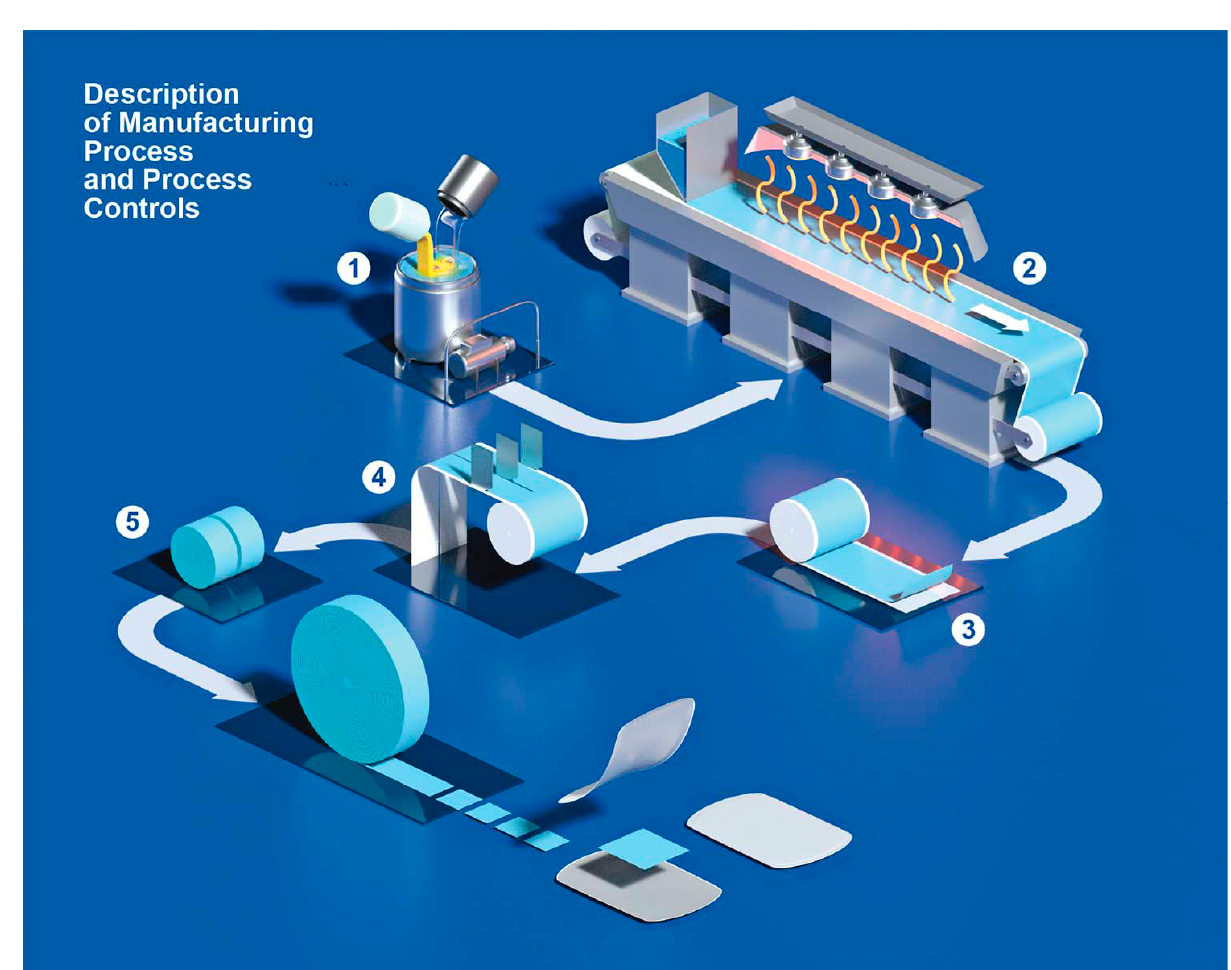
Figure 3. Description of industrial manufacturing process of ODF. The solvent-casting method, used to manufacture orodispersible films, consists of several steps. 1: During the first step, a liquid mixture is prepared; temperature and stirring speed are the critical process parameters. 2: Afterwards, the mixture is spread and dried in a drying tunnel by controlling temperature, air circulation, humidity and coating speed. 3: The dried and spread mixture is wound to form a big roll, called a Jumbo roll. 4: The jumbo roll is unwound to undergo two consecutive cutting phases, where the size of the film strips is selected and the final dosage is defined. 5: In the last step, the films are punched, pouched and sealed in suitable single-dose sachets.